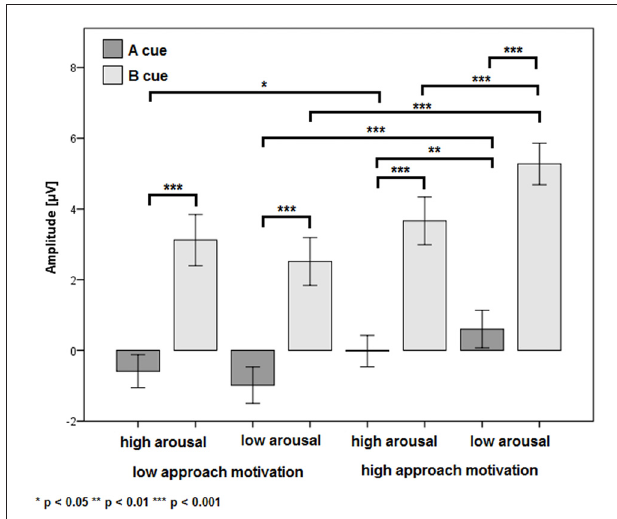
FIGURE 4 | The P3b amplitude as a function of AROUSAL × APPROACH MOTIVATION × CUES. Error bars represent one standard error of the mean.